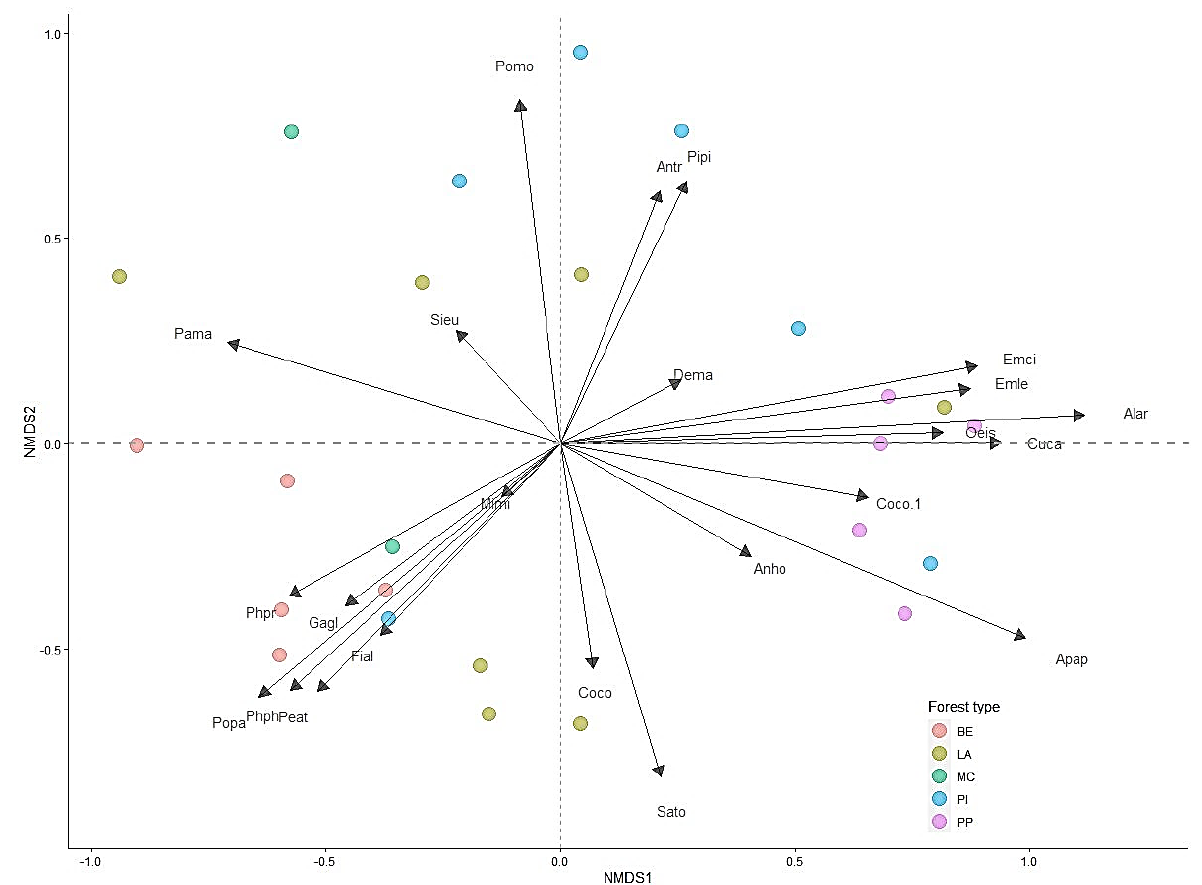
Figure 4. Non-metric multidimensional scaling (NMDS) ordination of selected bird assemblages in different habitat types in the forest of the Khentii Mountains. Forest types are deciduous woodland (DW), larch (LA), pine (PI), pine plantation (PP), and mixed conifer (MC). Note: Species names are generic acronyms or the four letters of the scientific names in Table 1. Table 4. SIMPER analysis of dissimilarity among forest habitat types by most abundant